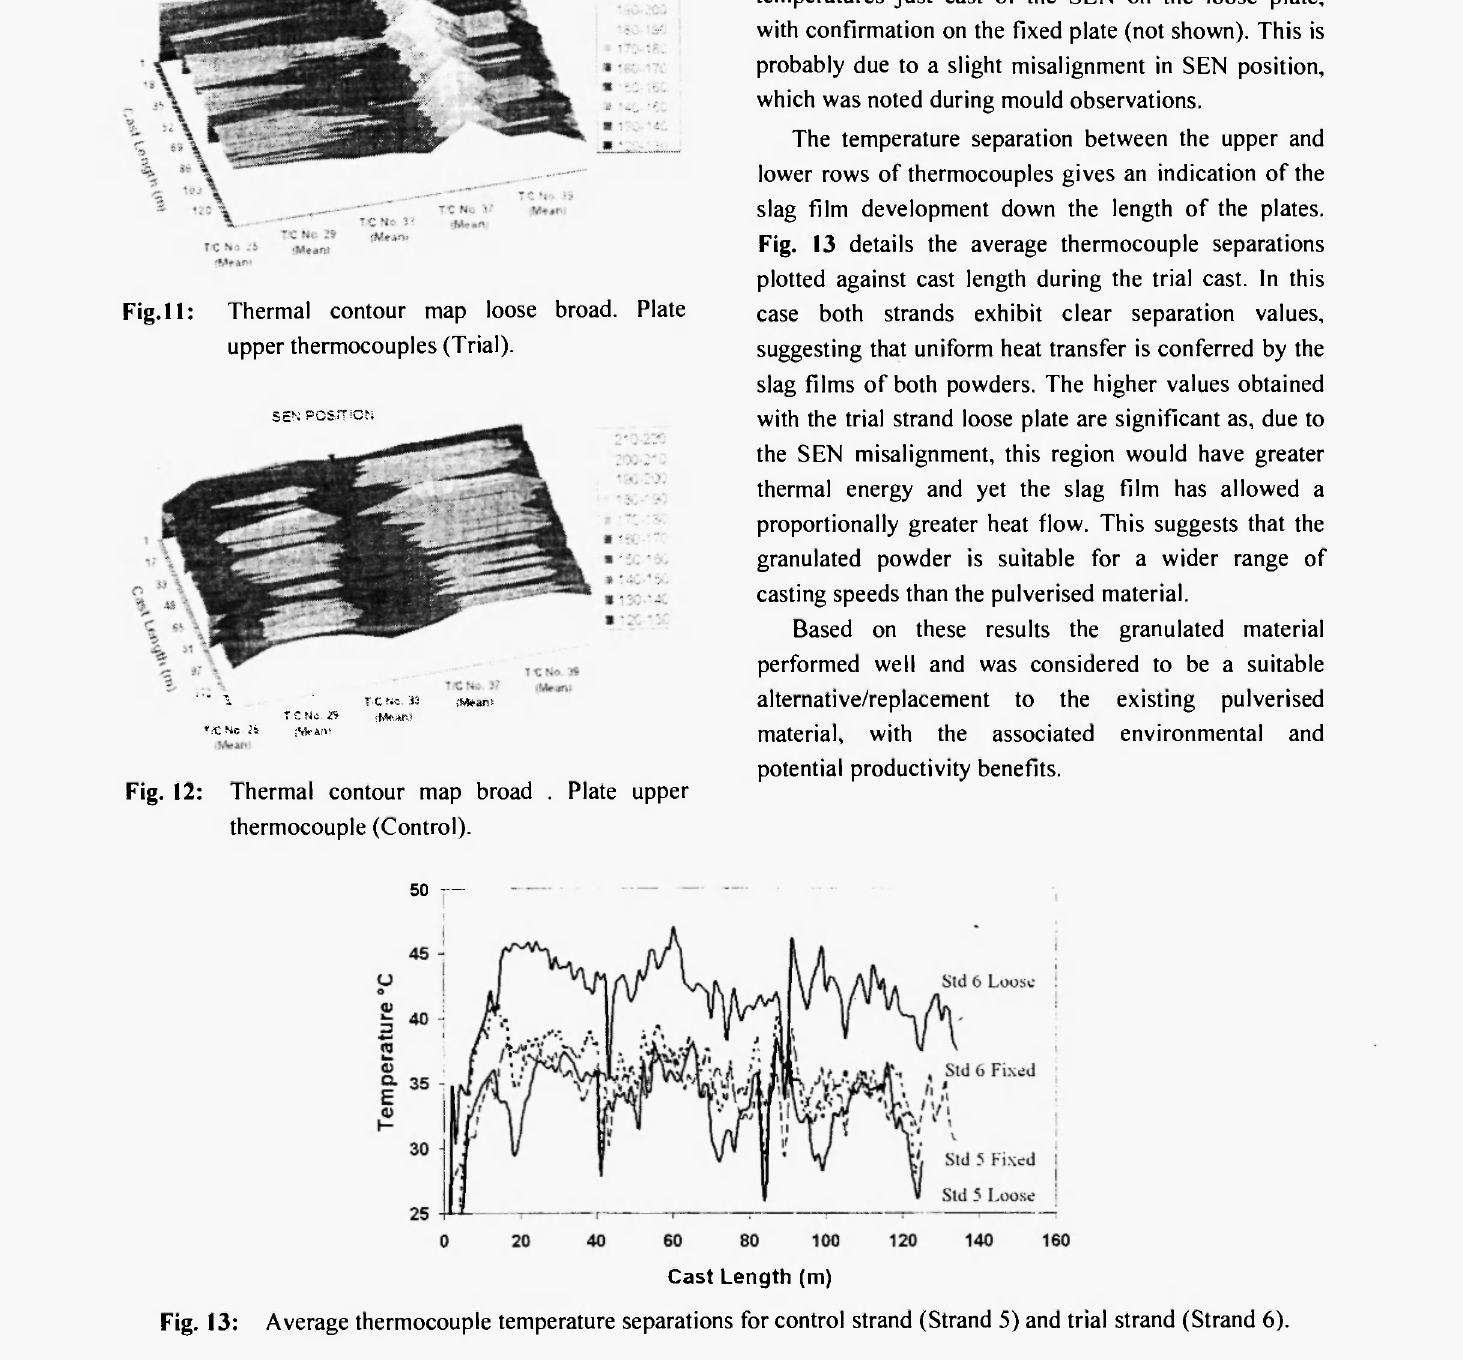
Figs. II and 12 show thermal contour maps for the